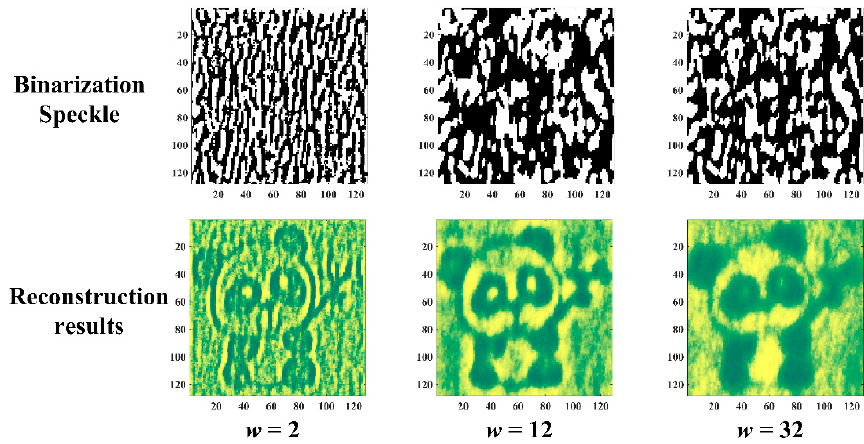
Figure 9. The reconstructed results of image panda with the hyper-parameter w .